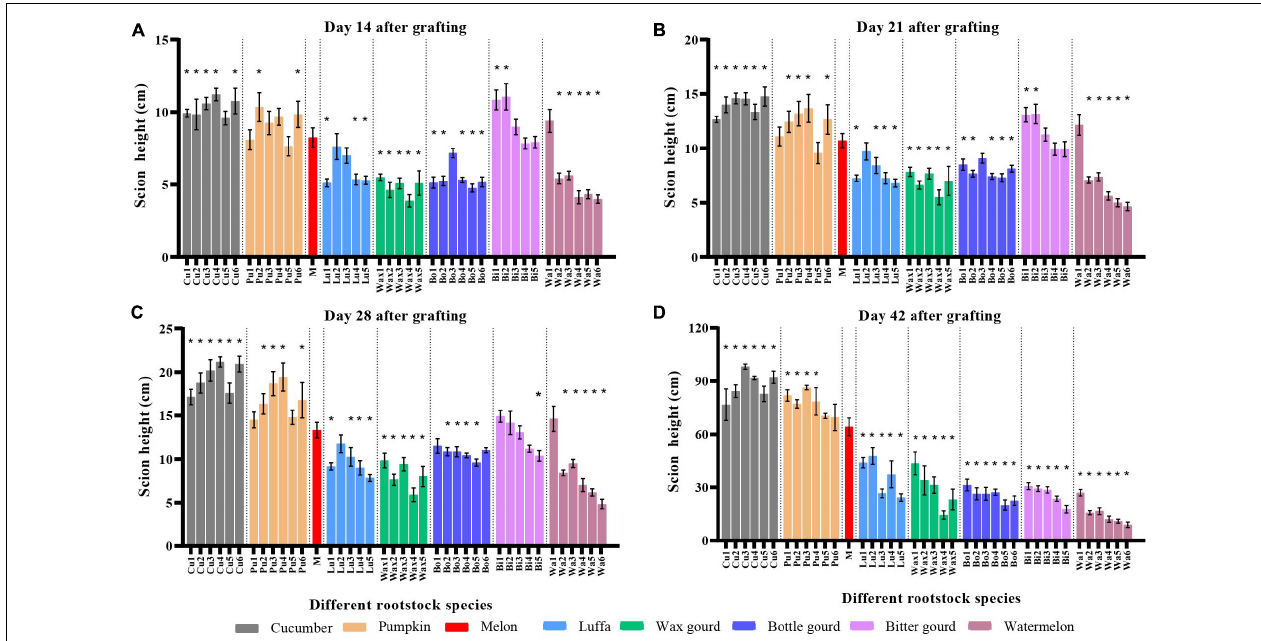
FIGURE 2 | Scion height of melon grafted onto eight Cucurbitaceae species. Scion height of melon cv. ‘Akekekouqi’ grafted onto cucumber (Cu1–Cu6), pumpkin (Pu1–Pu6), melon (M), luffa (Lu1–Lu5), wax gourd (Wax1–Wax5), bottle gourd (Bo1–Bo6), bitter gourd (Bi1–Bi5), and watermelon (Wa1–Wa6) on day 14 (A) , day 21 (B) , day 28 (C) , and day 42 (D) after grafting. Asterisks indicate a significant difference between melon homo-grafted plants and hetero-grated plants using the Student’s t -test ( p < 0.05).